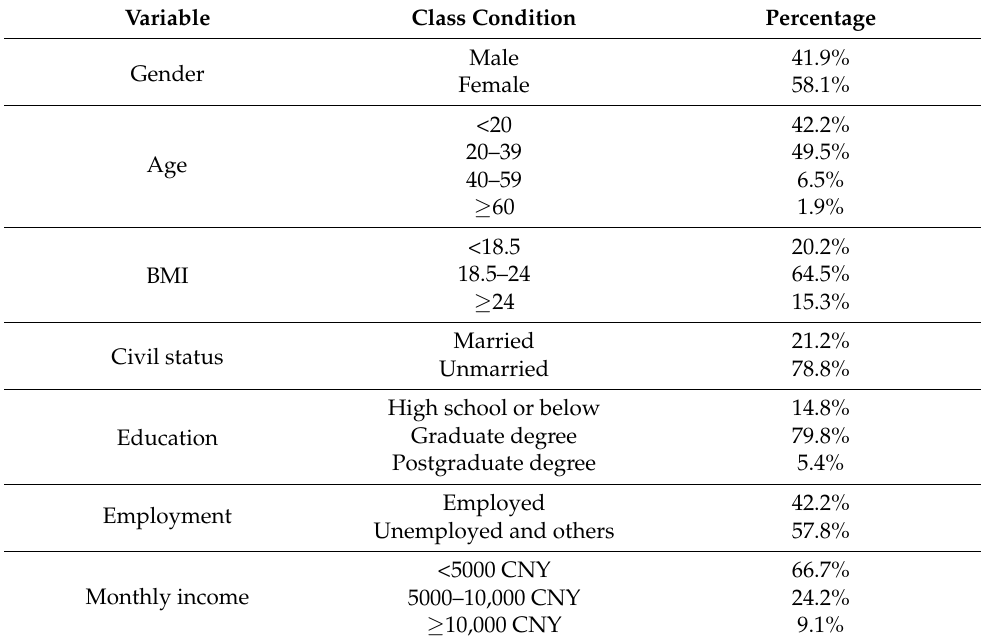
Table 3. Socio-demographics of respondents in